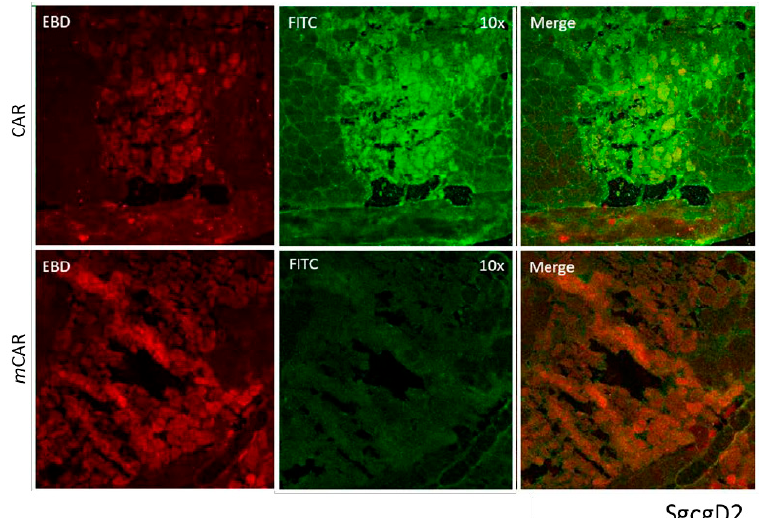
Figure 2. The CAR peptide co-localized to damaged (indicated by EBD staining) muscle cells in the SgcgD2 mice. These mice were injected IV with either the CAR-FITC or the mCAR-FITC peptide. The EBD positive fibers (red) demonstrated co-localization with FITC coupled CAR peptide (green). The mCAR peptide (FITC coupled) did not co-localize to the damaged, EBD positive fibers. Original magnification was 10×.